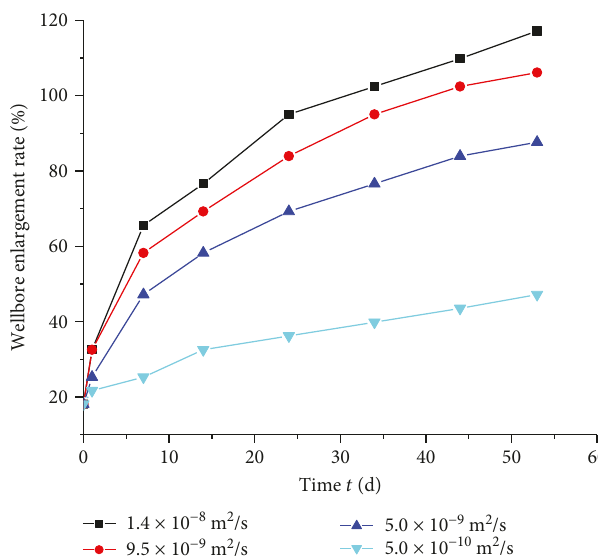
Figure 20: Curve of the wellbore enlargement rate with time under di ff erent shale